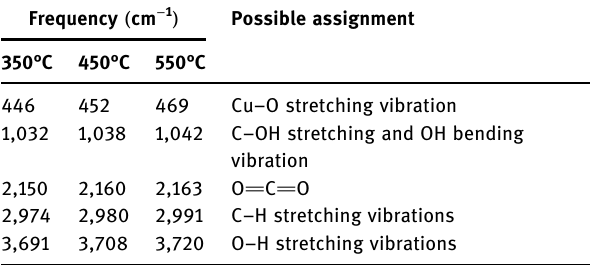
Table 2: FTIR spectra with possible assignments for CuO samples calcinated at 350, 450, and